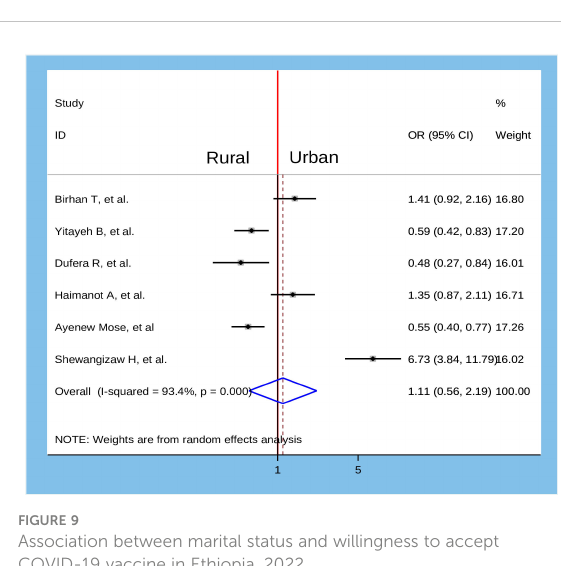
FIGURE 9 Association between marital status and willingness to accept COVID-19 vaccine in Ethiopia, 2022.